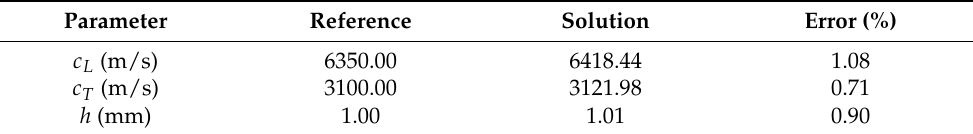
Figure 4. Group velocities ratios (circles) derived from the acoustic signals at different frequencies and the corresponding fitted model (solid line) for ( a ) simulated data and ( b ) experimental data. Table 1. Results for simulated data.